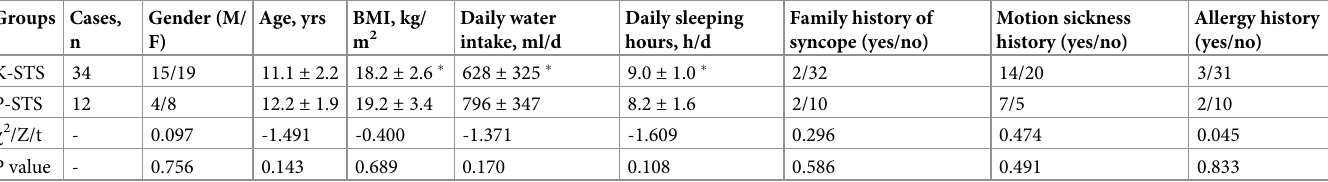
STS, sitting-induced postural tachycardia syndrome; K-STS, children, and adolescents with sitting tachycardia syndrome from Kaifeng city; P-STS, children and